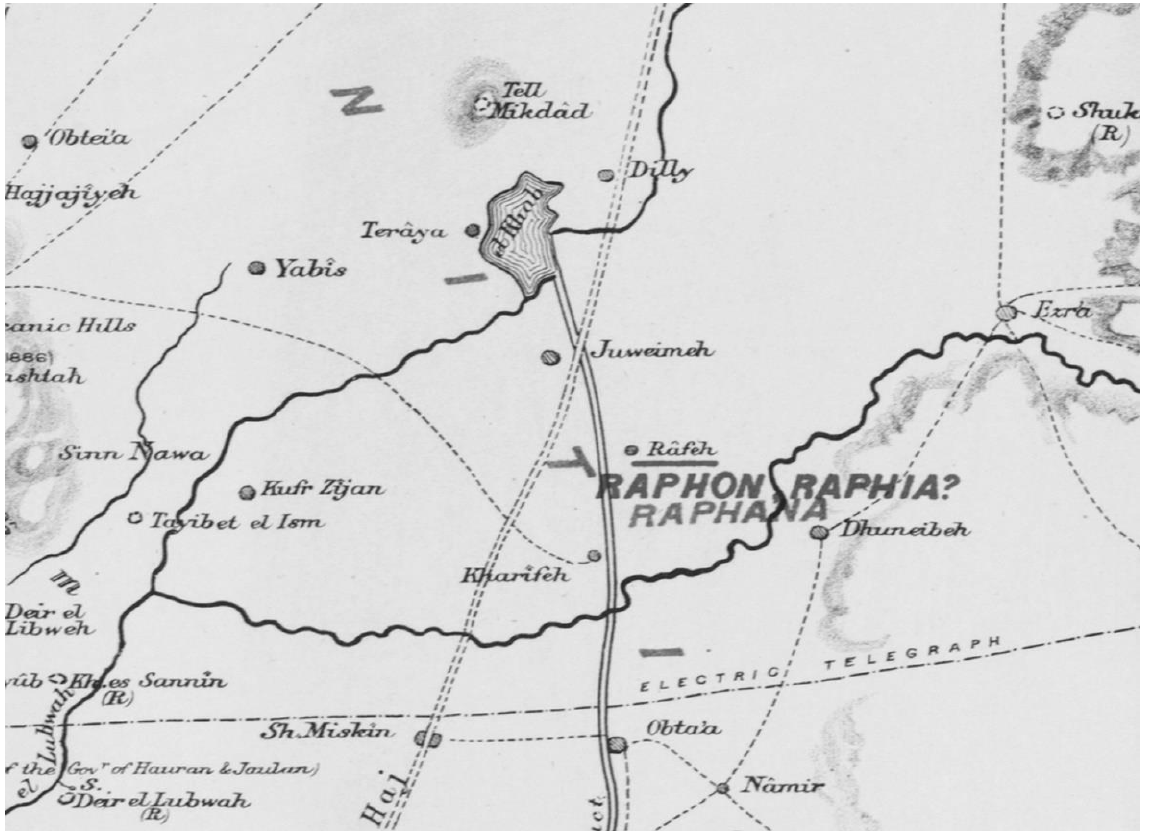
Figure 3: Map section of the PEF Map Sheet 7, M1: 168960 Edition 1910